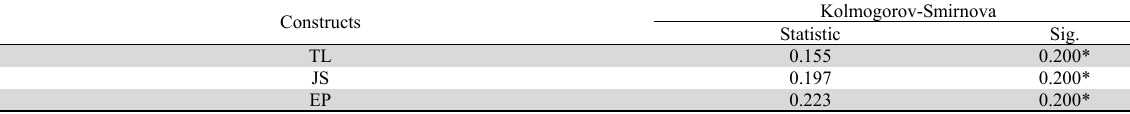
Tests of data normality